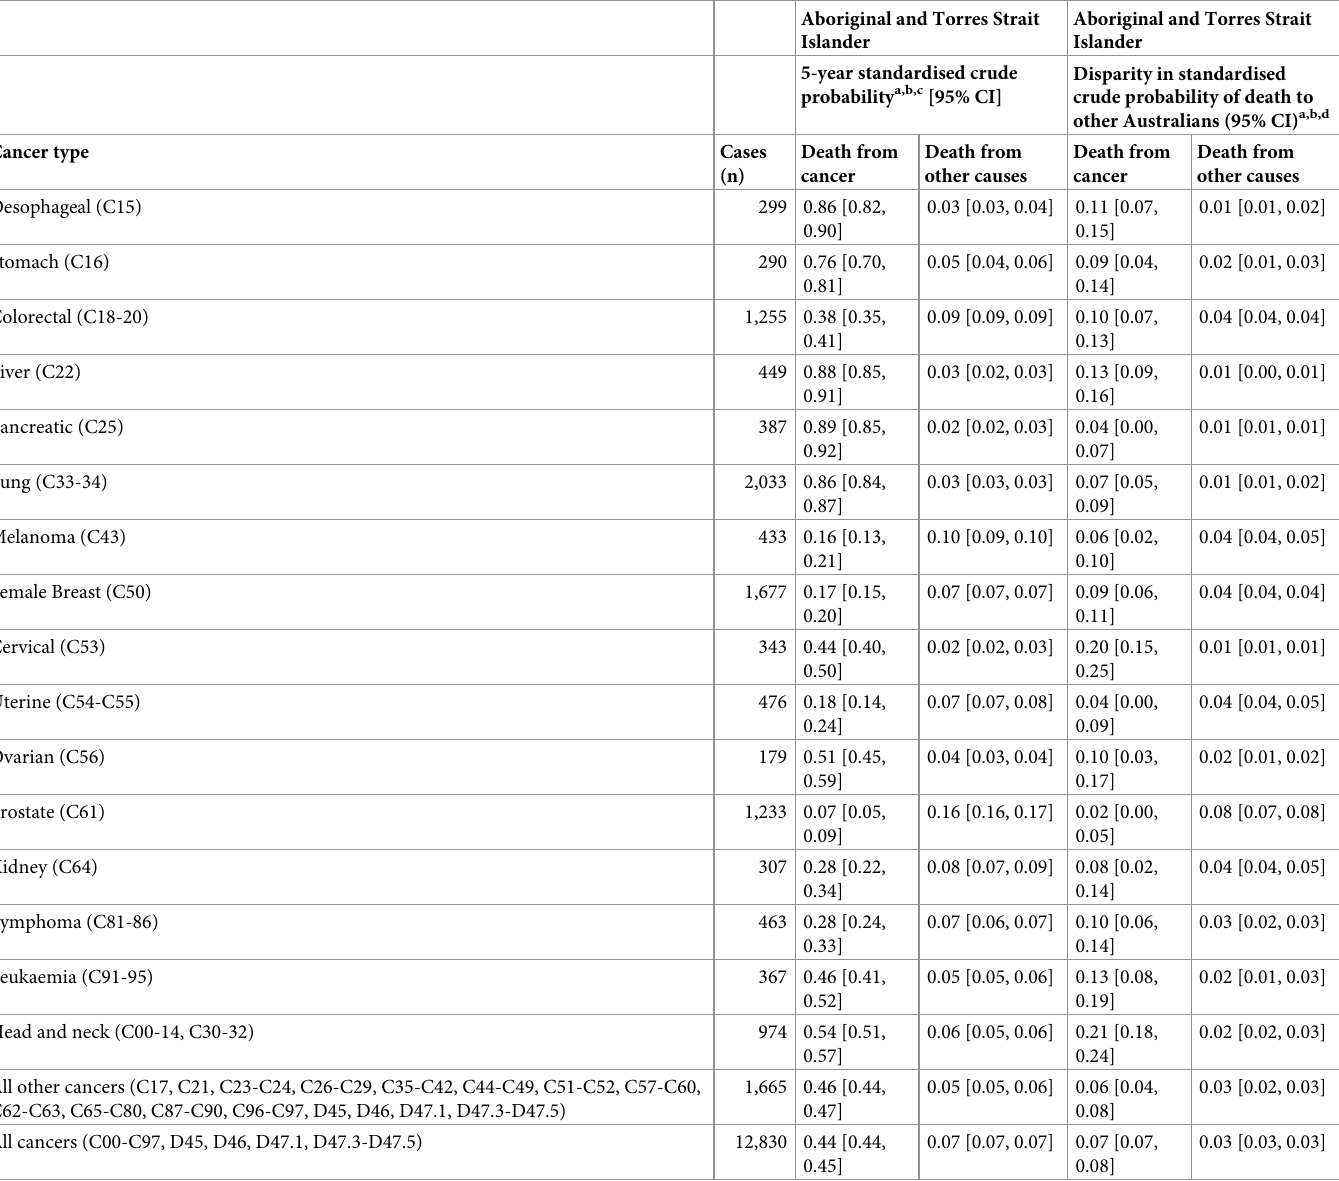
Table 1. Estimated standardised crude probability of death from cancer, death from other causes and being alive, Aboriginal and Torres Strait Islanders and dispar- ity in estimated probabilities of death, to other Australians, Australia, five years since diagnosis, by cancer type, Australia,